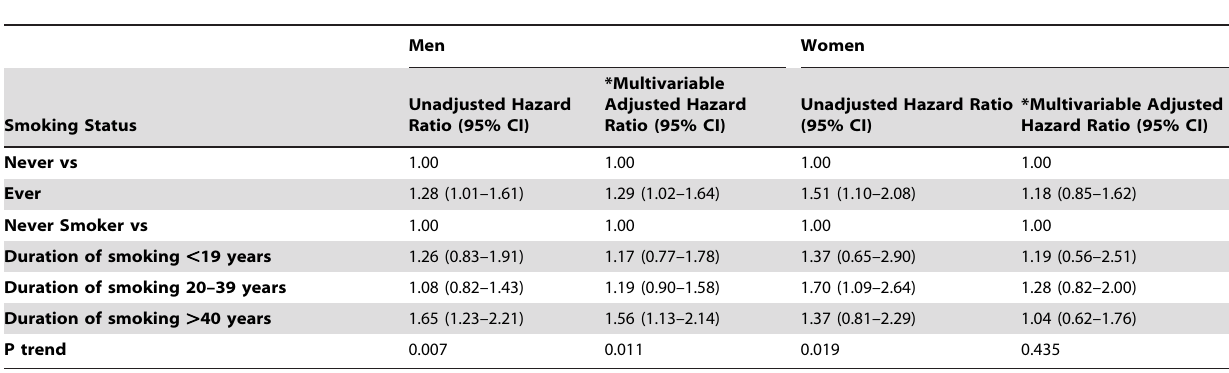
Table 4. Unadjusted & Adjusted Risk of Kidney Failure in Chinese Men and Women by Smoking